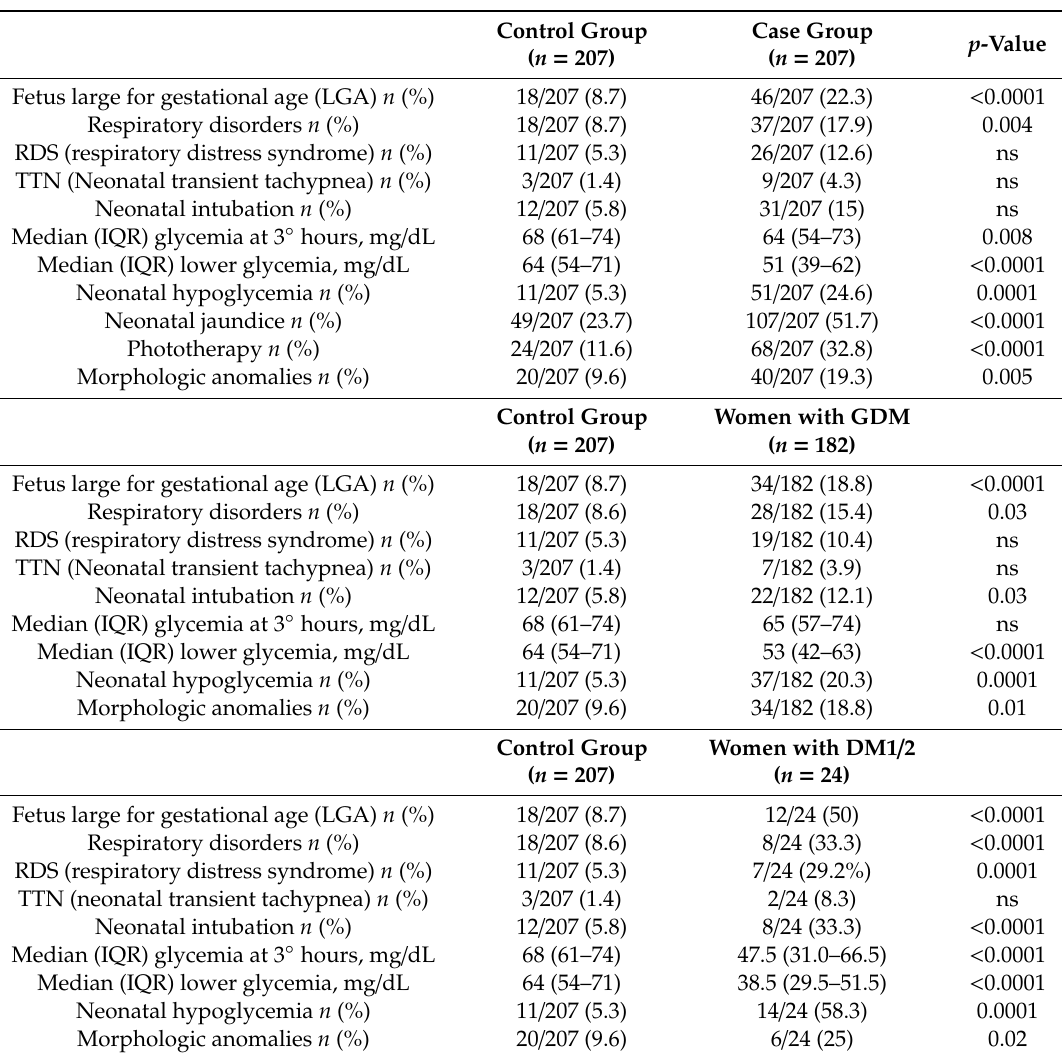
Table 3. Neonatal